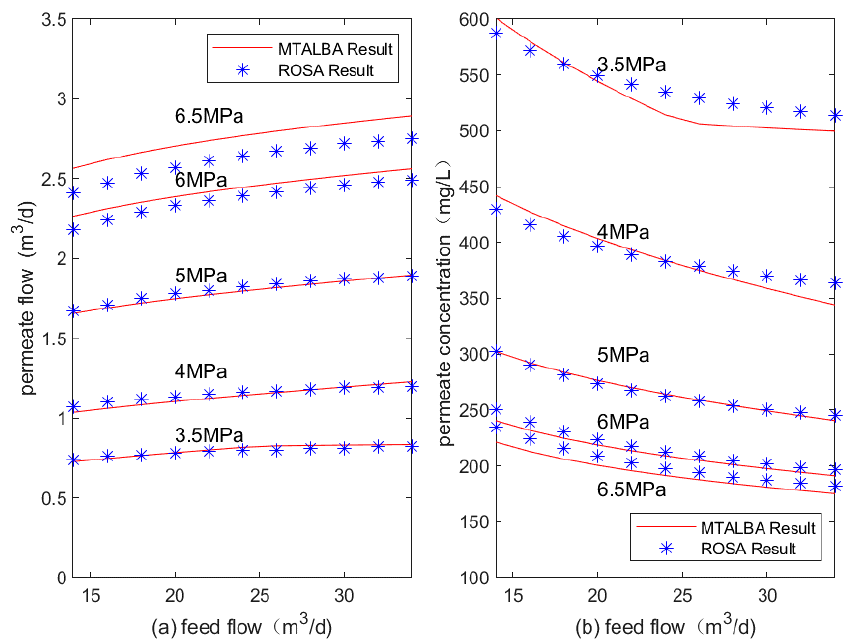
Figure 3. Comparison of MATLAB simulation results with ROSA9.0. ( a ) Relationship between feed water flow rate and produced water flow rate under different pressures; ( b ) relationship between feed water flow rate and produced water flow rate under different pressures.